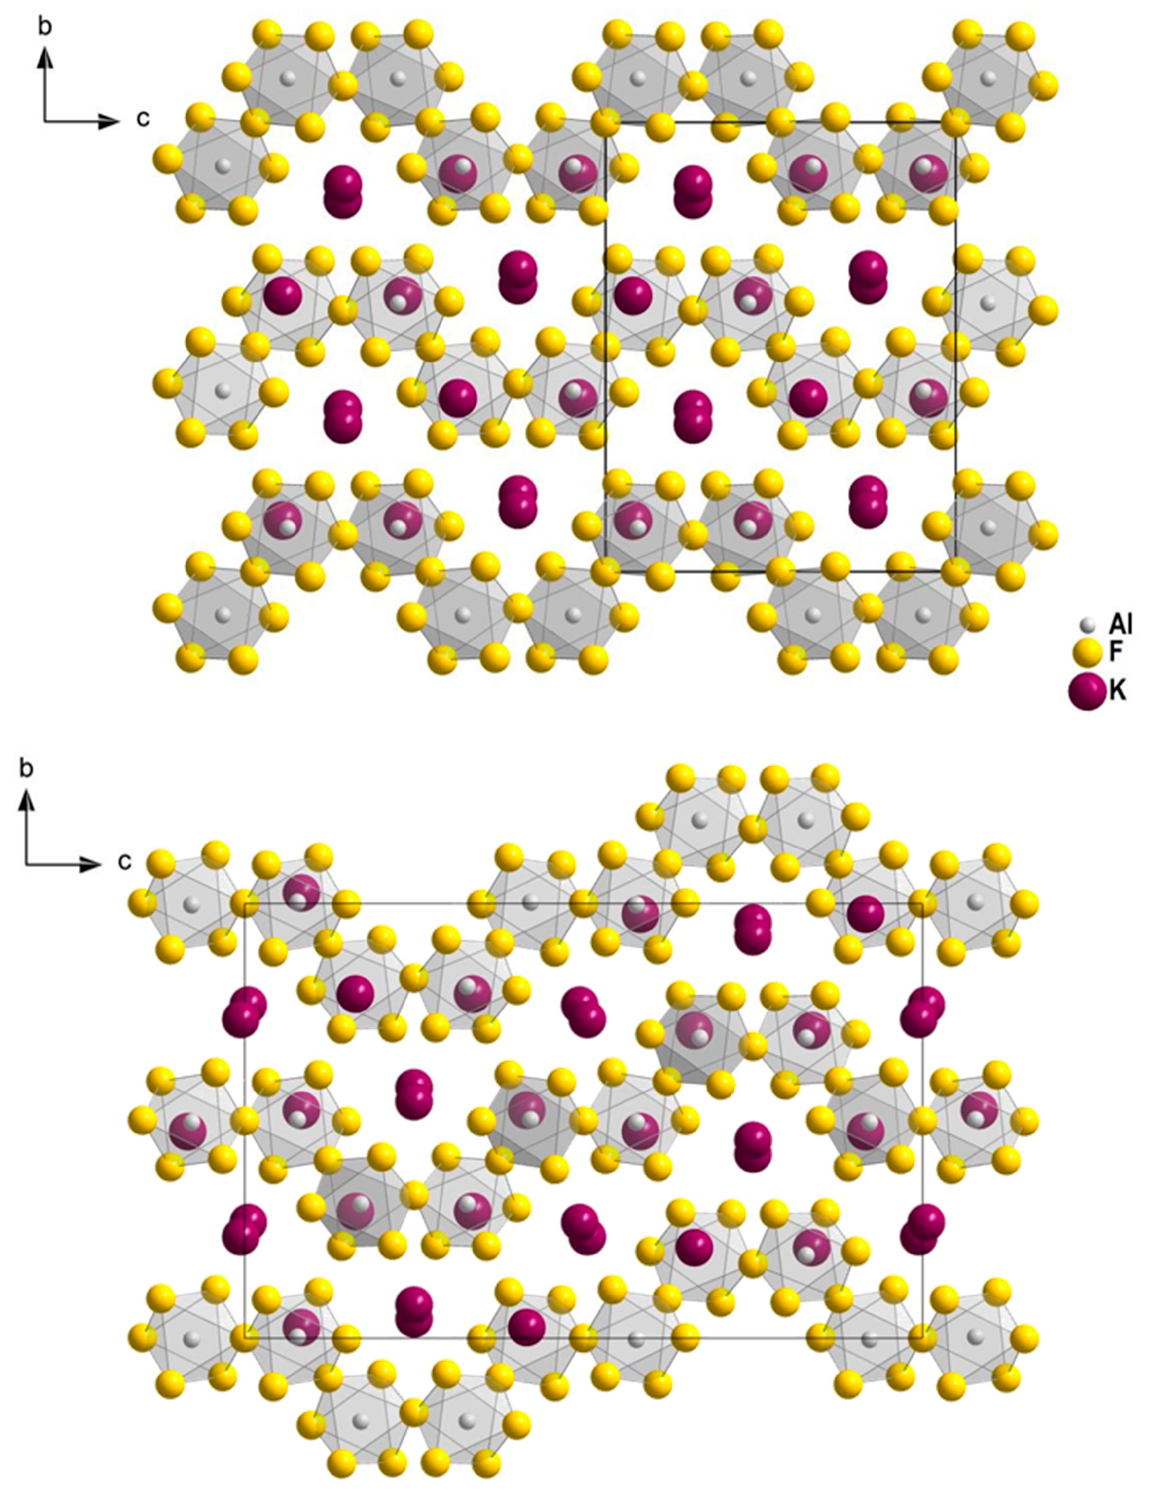
Figure 1. Sections of the crystal structures of K 2 AlF 5 -2 ( top ) and K 2 AlF 5 -3 ( bottom ), viewing direction [100]. Table 1. Selected crystallographic parameters and refinement data of K 2 AlF 5 -2, K 2 AlF 5 -3, and Rb 2 KAlF 6 .